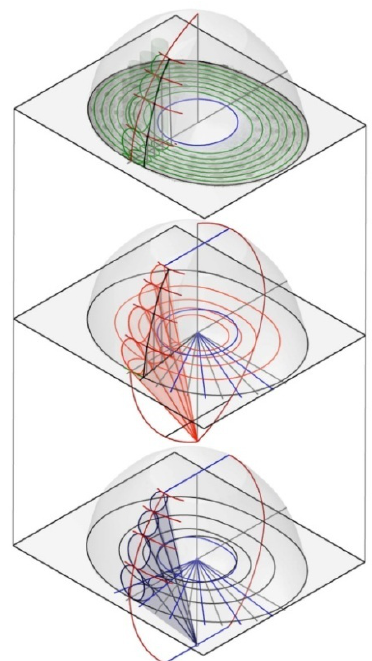
Figure 17. Research in progress: projection hypothesis for ovoidal coffered